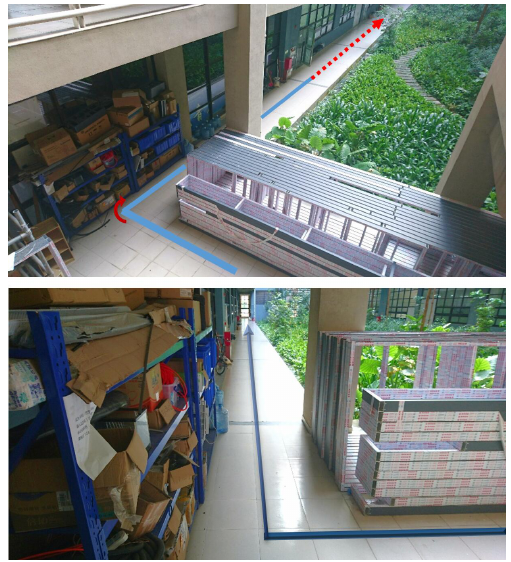
Figure 11. Real world experiment in the sunny morning. The array is the robot trajectory, where the red dotted line in the upper figure is the place where obstacle avoidance happens.